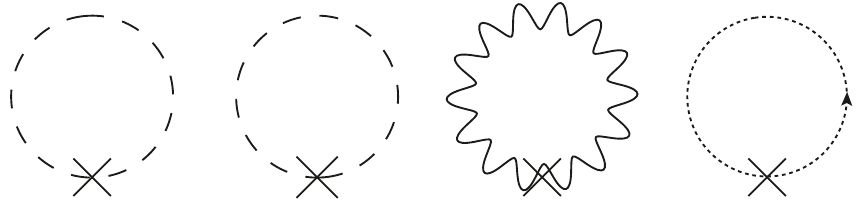
Figure 15 . The Feynman diagrams contributing to the one-loop energy-momentum tensor for the Abelian Higgs model. There are four separate contributions. The Higgs field and the Goldstone boson diagrams are denoted by long dashed lines, the massive gauge boson is the wiggly diagram and the ghost contribution is the short-dashed